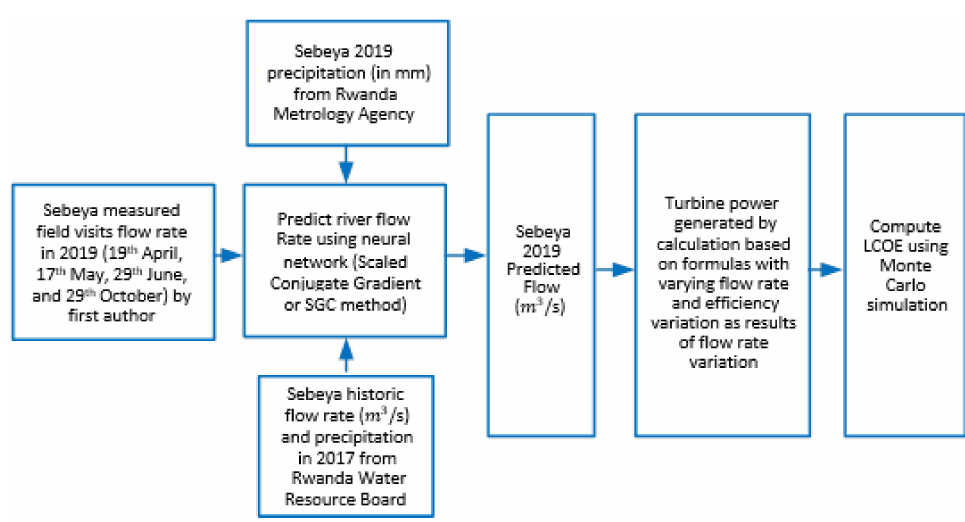
Figure 1. Methodology for estimating river flow